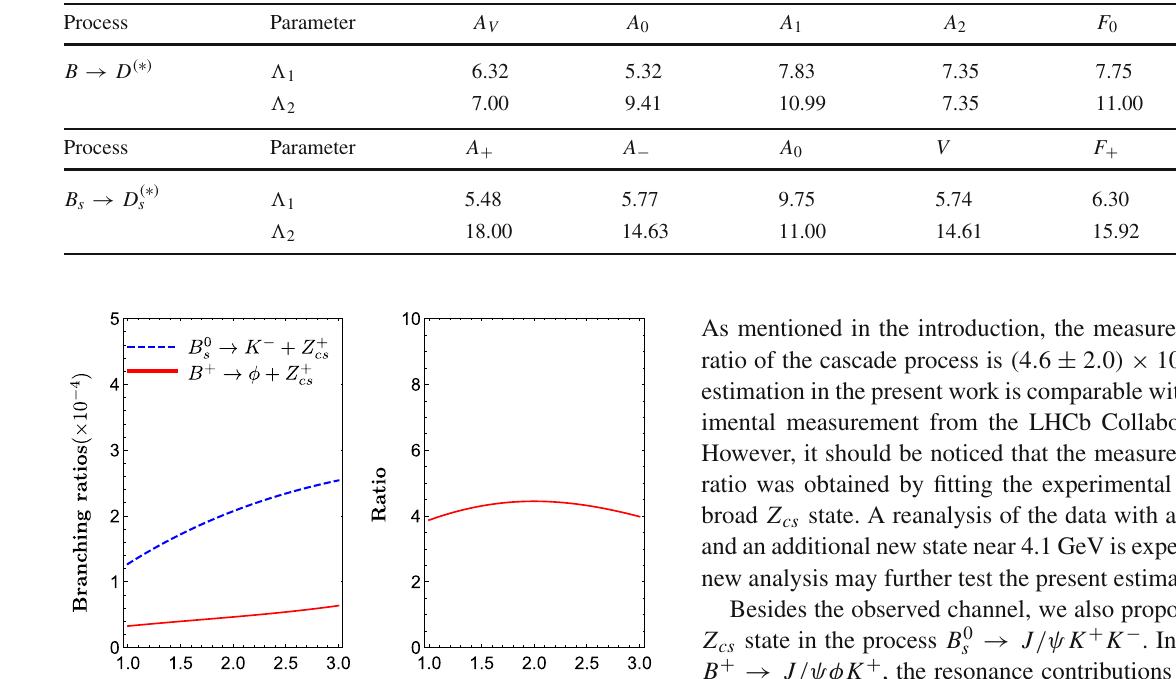
Table 3 Values of the parameters (cid:21) 1 and (cid:21) 2 obtained by fitting the form factor